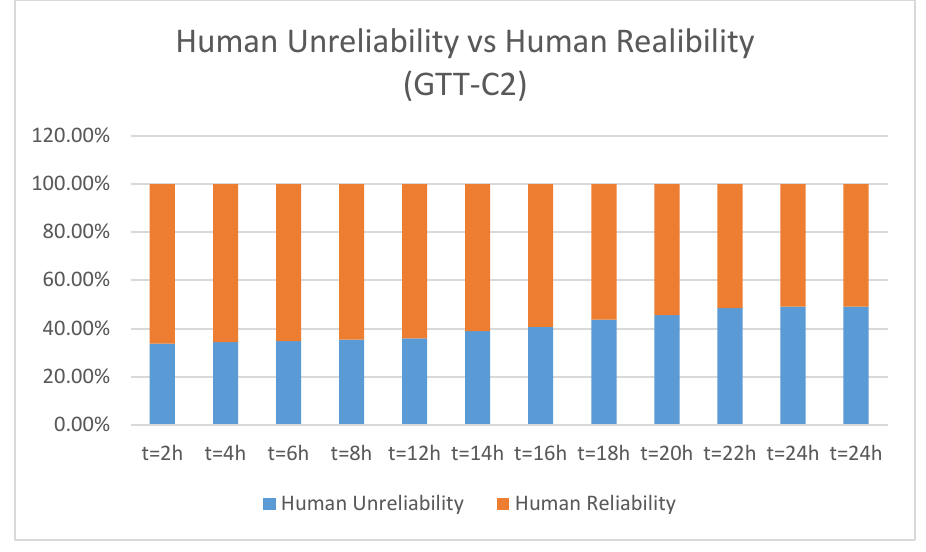
Figure 4. HEP SHRA vs HRA SHRA